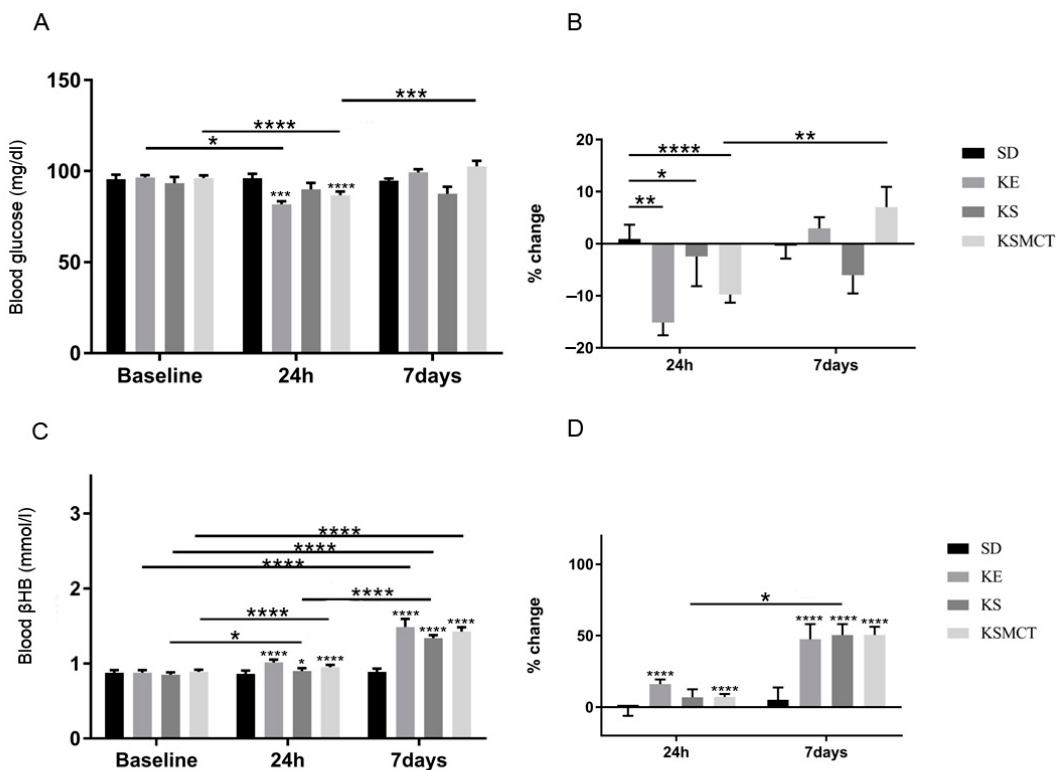
Figure 5. Changes in blood glucose and R - β HB levels of 6-month-old WR rats after 24 h and seven days of treatment, in rested state. ( A ) The change in glucose levels in WR rats, with no exercise, for the baseline, after 24 h and after seven days of daily treatment. ( B ) The corresponding percent change in glucose levels. ( C ) The resulting blood R - β HB levels. ( D ) The percent change in the blood R - β HB